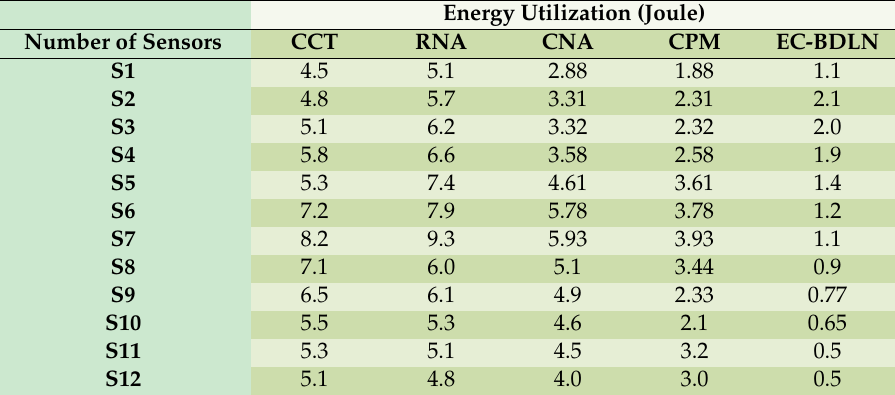
Table 5. Energy utilization of various algorithms. Energy Utilization